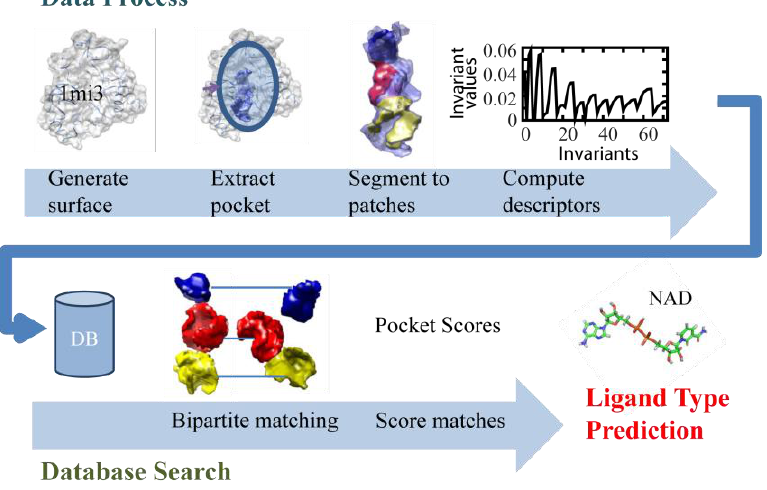
Figure 1. Flow chart of the local surface patch prediction